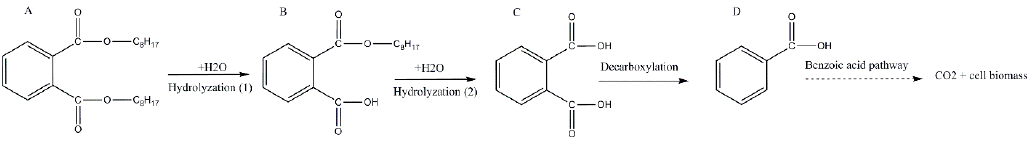
Figure 6. The proposed degradation pathway of di (2-ethylhexyl) phthalate by strain YC-IL1. Letters represent degradation intermediates; ( A ) di (2-ethylhexyl) phthalate, ( B ) monoethylhexyl phthalate, ( C ) phthalic acid, ( D ) benzoic acid.